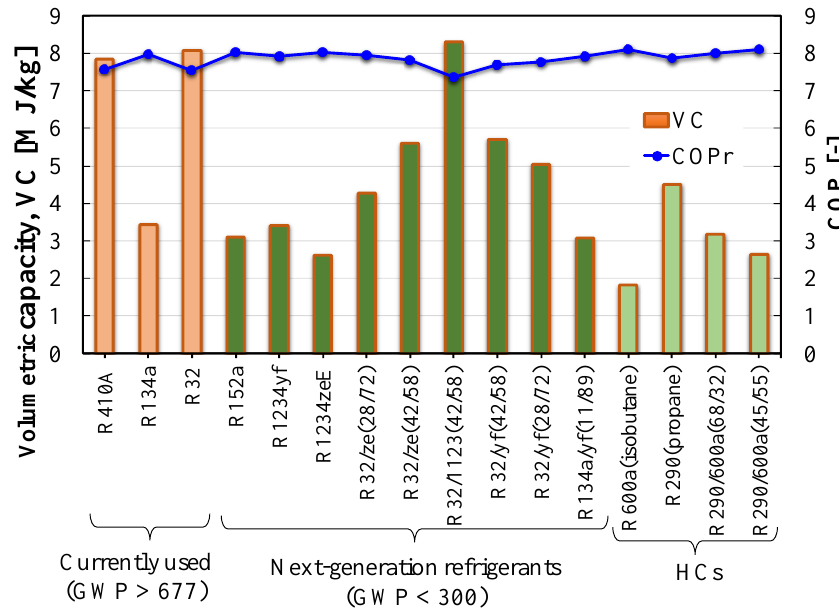
the compressor and the heat exchanger for drop-in replacement.